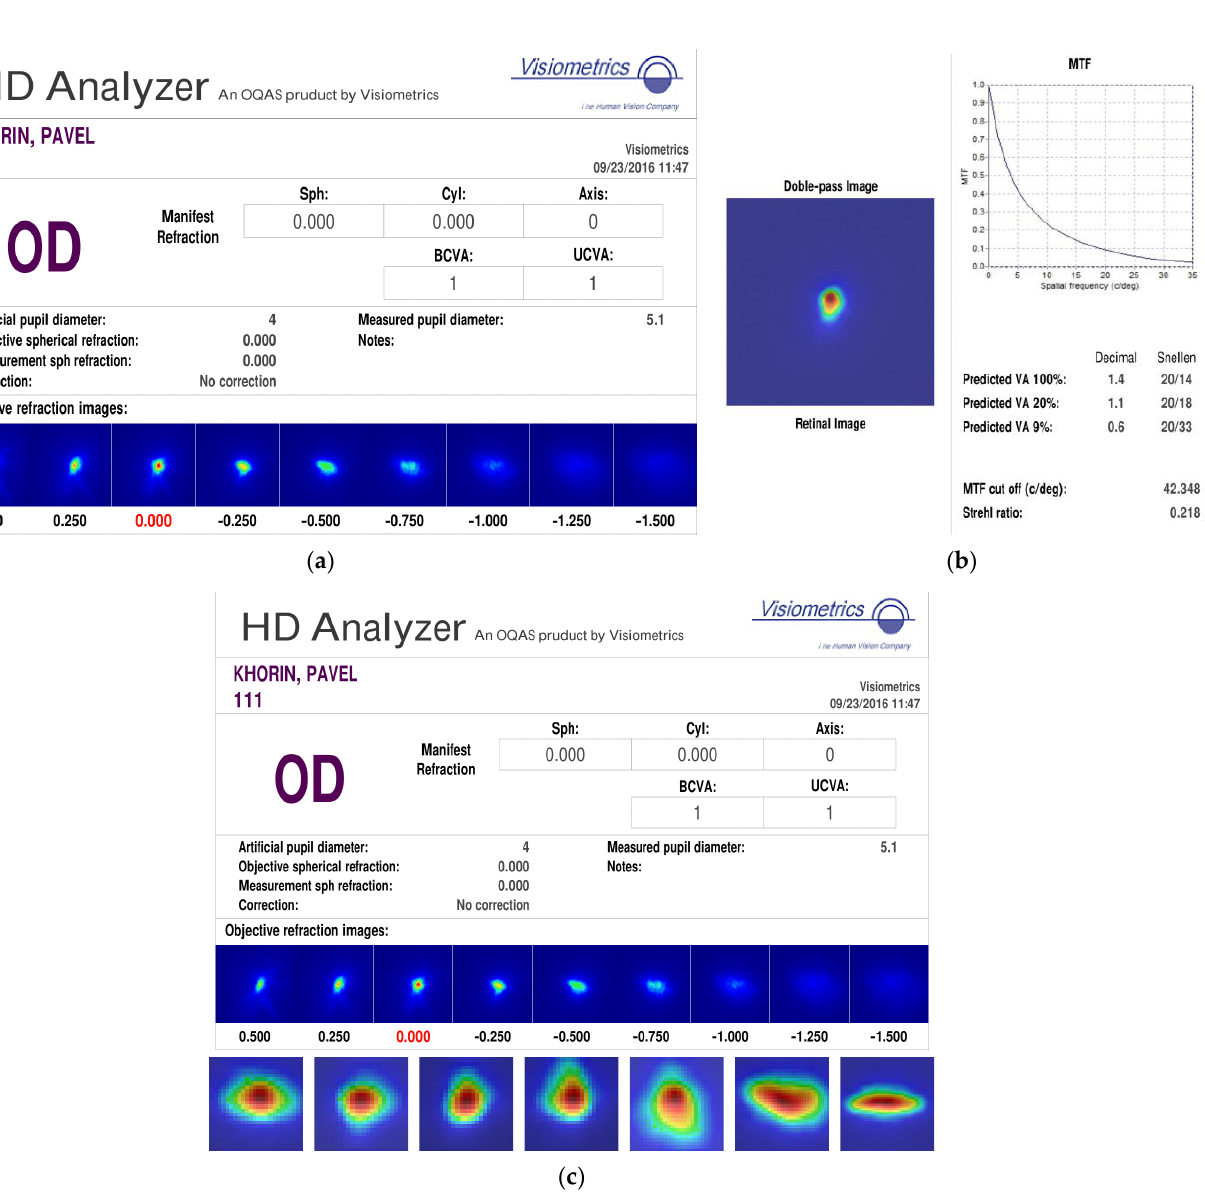
Figure 4. Report of the diagnostic device based on the results of a study of a healthy eye ( a , b ); PSF on the retina of patients without pathologies ( c ).